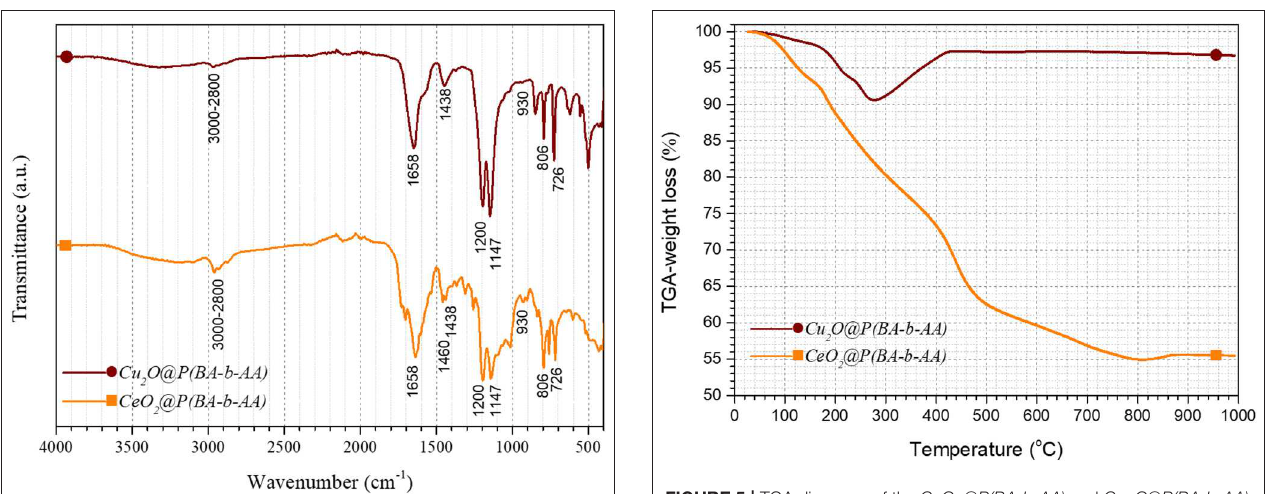
FIGURE 5 | TGA diagrams of the CeO 2 @P(BA-b-AA) and Cu 2 O@P(BA-b-AA) core-shell